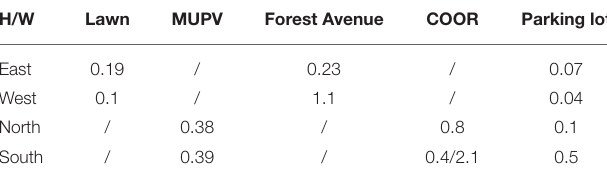
TABLE 2 | Height-to-width